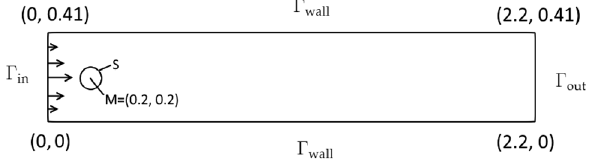
Fig. 4 The mesh after four steps of adaptive refinement for the drag